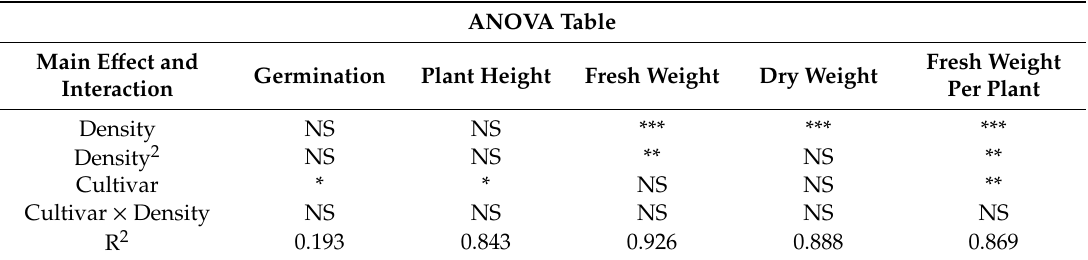
Table 5. Analysis of Variance for sowing density parameters and model-accounted variability R 2 .